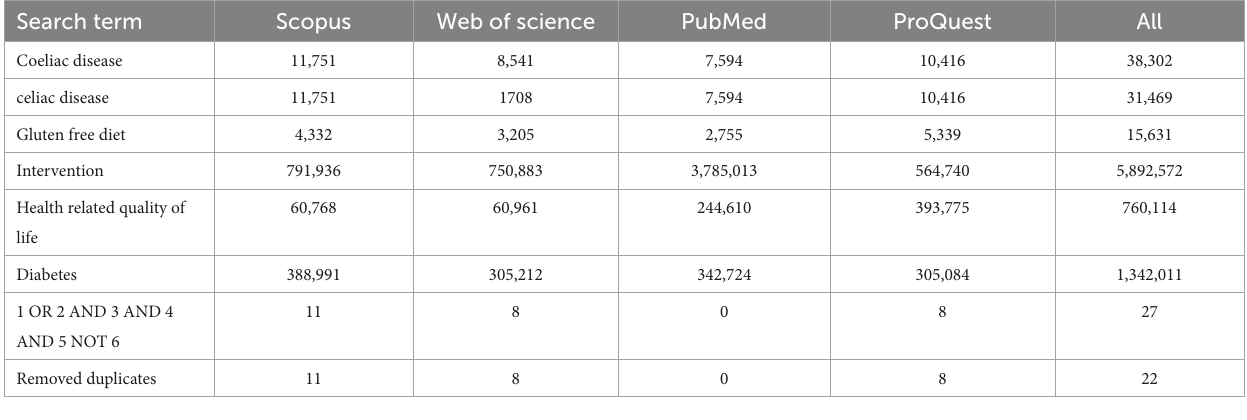
TABLE 1 Results generated through the database search.